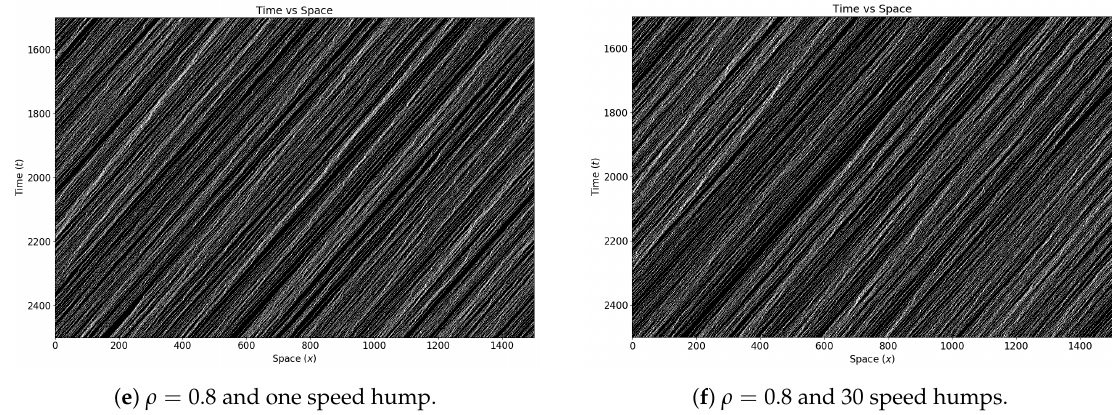
( f ) ρ = 0.8 and 30 speed humps. Figure 6. Time–space diagrams and different densities of vehicles.